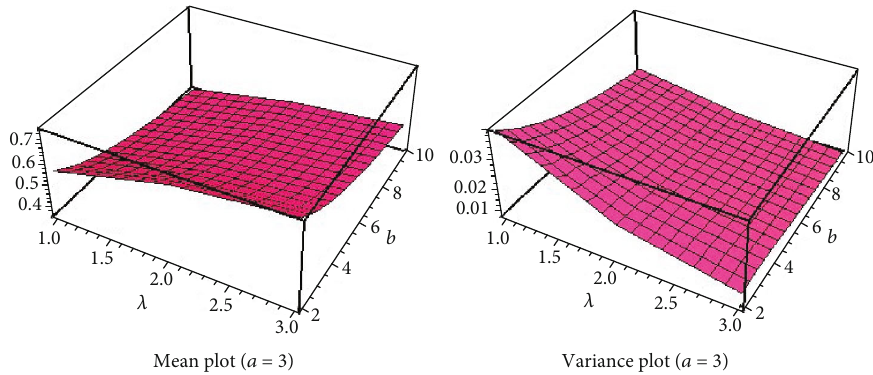
Figure 4: Graphs of mean and variance of TIIHLKw distribution.